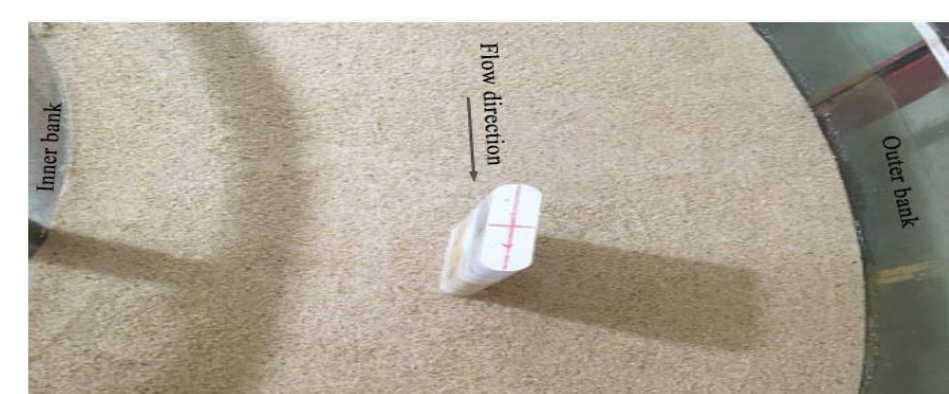
Figure 4. A view of the rectangular pier with an oblong nose, located in the 90 degree position in the